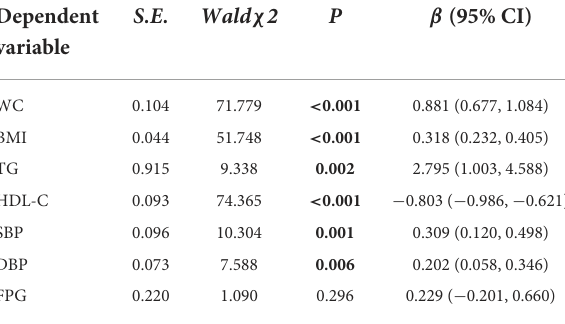
FPG,fastingbloodglucose.Statisticallysignificant p